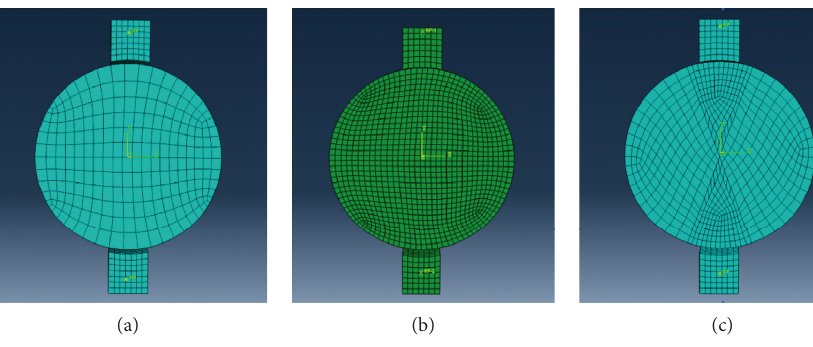
Figure 6: Three different meshing used in FE modeling: mesh (a), mesh (b), and mesh (c).